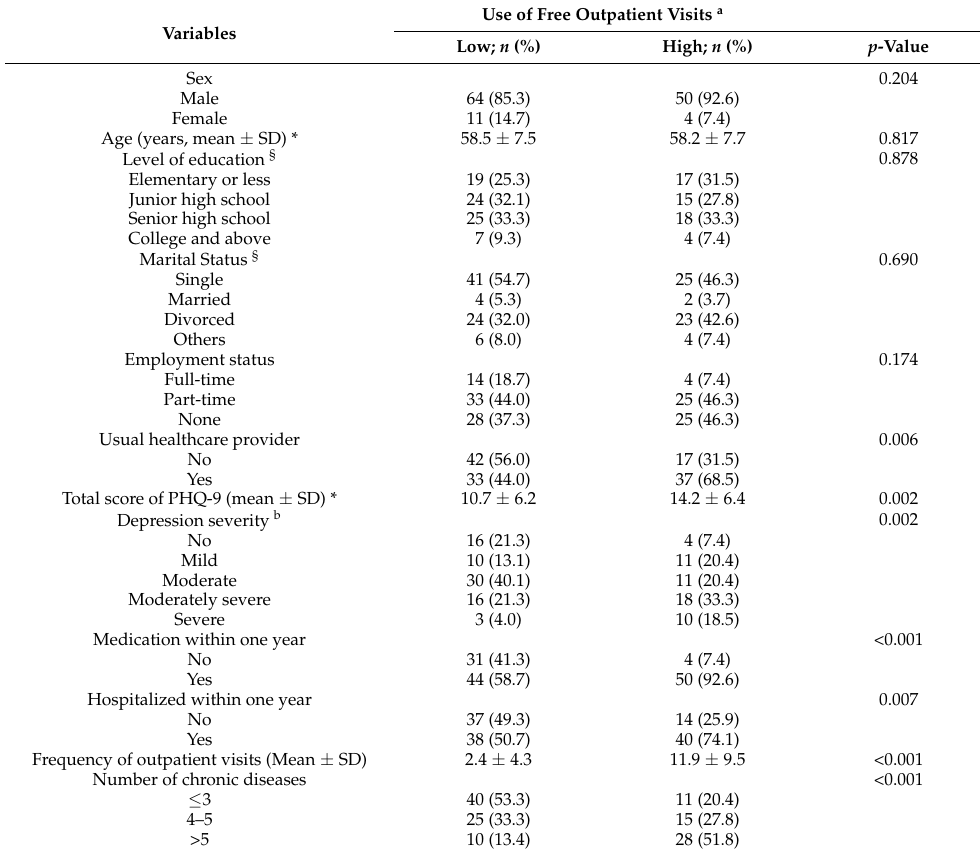
Table 3. One-way analysis of free hospital outpatient visits ( n = 129).